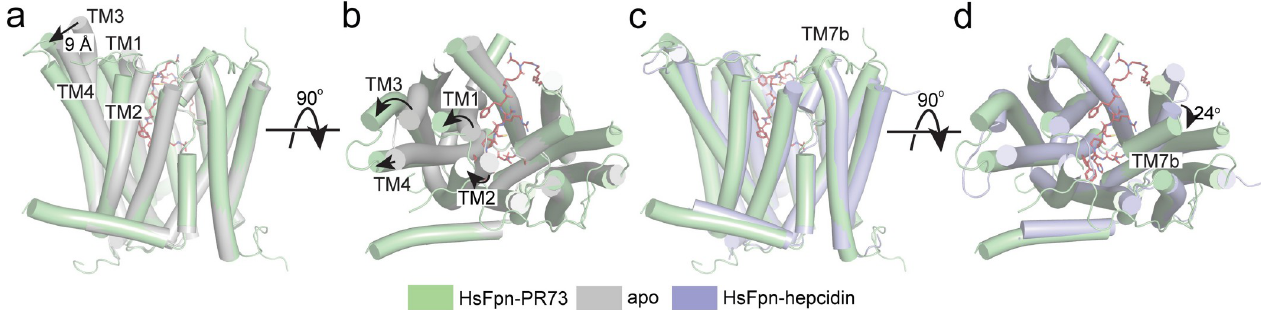
Fig 4. Structural changes induced by PR73. Structure of HsFpn-PR73 (pale green) aligned with apo-HsFpn (gray, PDB ID 6W4S) viewed from the side ( a ) and the extracellular side ( b ). Large structural changes are highlighted by arrows. Structures of HsFpn-PR73 aligned with HsFpn-Hepcidin (light blue, PDB ID 6WIK) viewed from the side ( c ) and extracellular side ( d